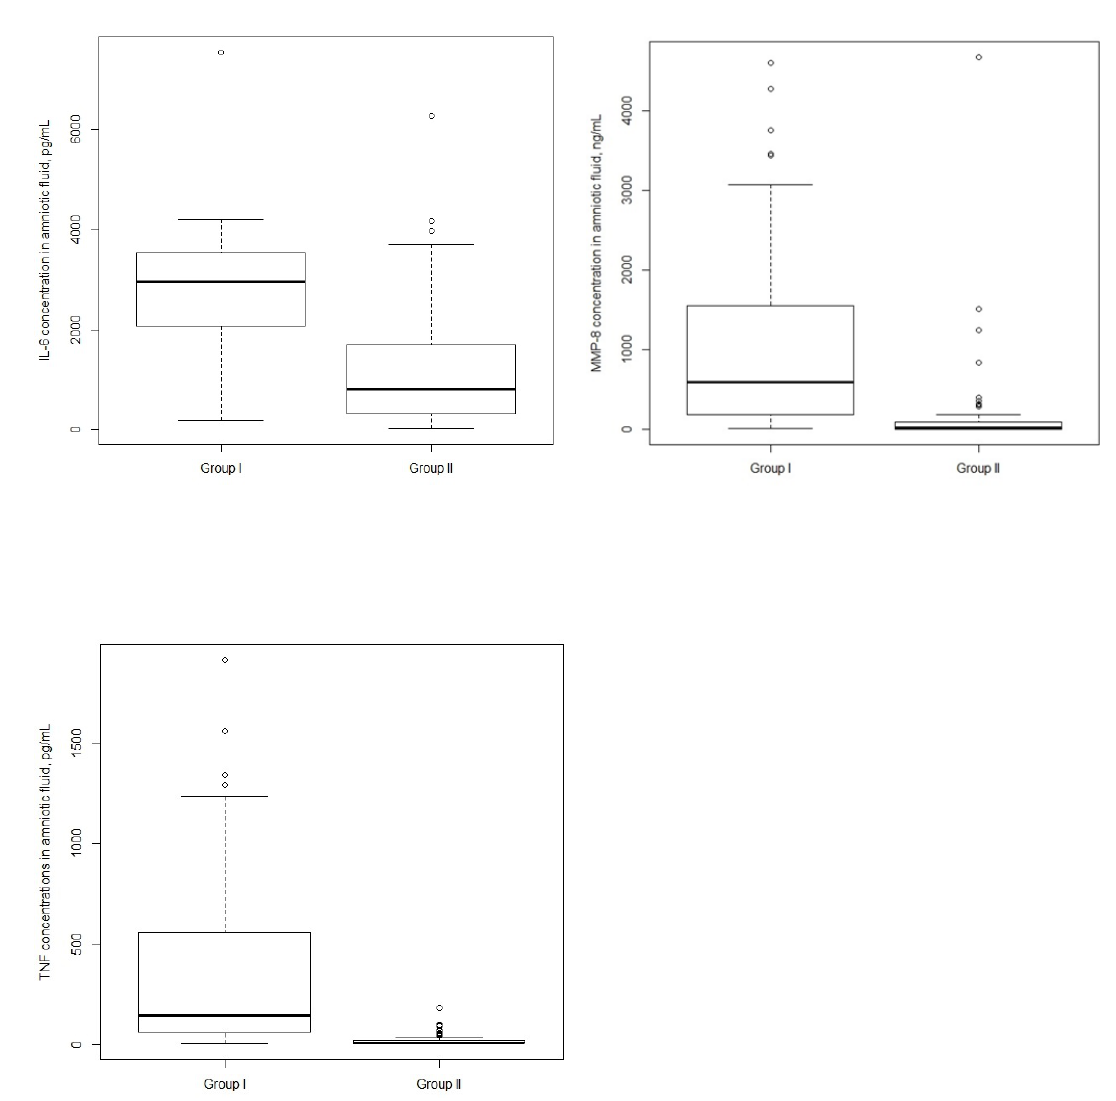
Figure 1. Interleukin-6 (IL-6), matrix metalloproteinase 8 (MMP-8), and tumor necrosis factor alpha (TNF- α ) concentrations in amniotic fluid. Women with the presence of histological chorioamnionitishad a higher median of IL-6, MMP-8, and TNF- α concentrations than women without histological chorioamnionitis. p -value < 0.001 for all 3 assays. Horizontal bars indicate the median values. Group I, patients with diagnosed histological chorioamnionitis and Group II, patients without diagnosed histological